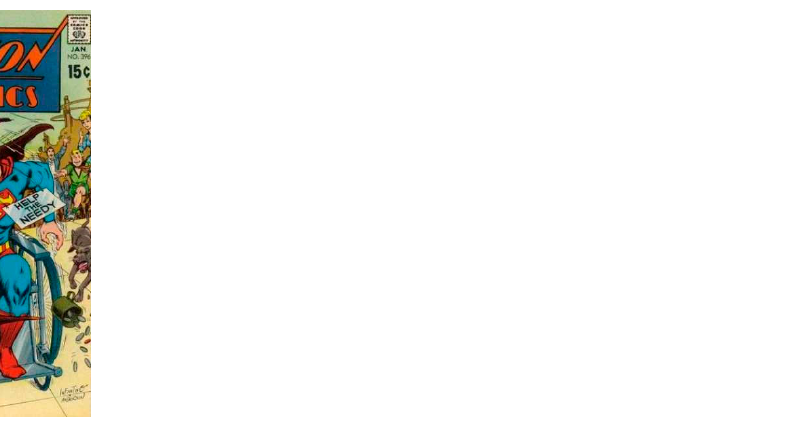
Figure 9. Action Comics #396, “The Super-Panhandler of Metropolis!” (January 1971) [10] .